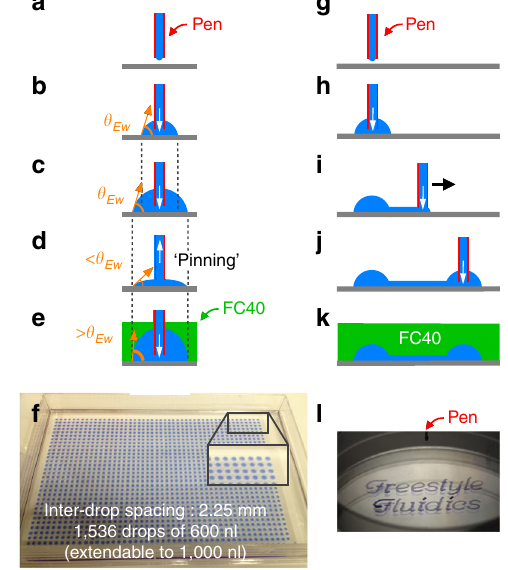
Fig. 1 Making circuits without solid walls. a – f Some principles. θ Ew : equilibrium contact angle (media in air). a , b Ejected media is held in place by surface tension. c Adding media increases the footprint, but d removing large amounts does not. e Overlaying FC40 allows more media than in ( c ) to be added without altering the footprint because the equilibrium contact angle of media under FC40 is greater. f Array of 1536 drops of media plus blue dye under FC40 in a fl at microtiter plate lacking wells ( inset shows magni fi cation). The pen ejected fl uid continuously as it deposited drops (locations as in a conventional 1536-well plate). g – k Steps in printing a simple circuit. See text. l Example circuit printed in ∼ 40 s in air using media mixed with blue dye in a 6-cm tissue-culture dish. It is not yet overlaid